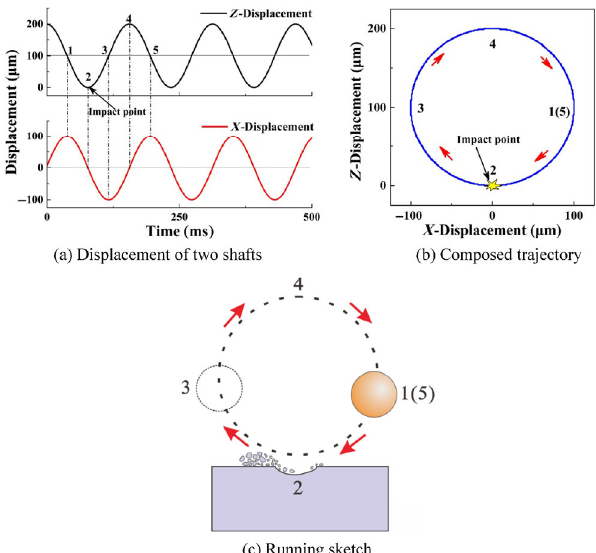
Fig. 3 Theoretical displacement of the two directions and composed trajectory under unidirectional motion.